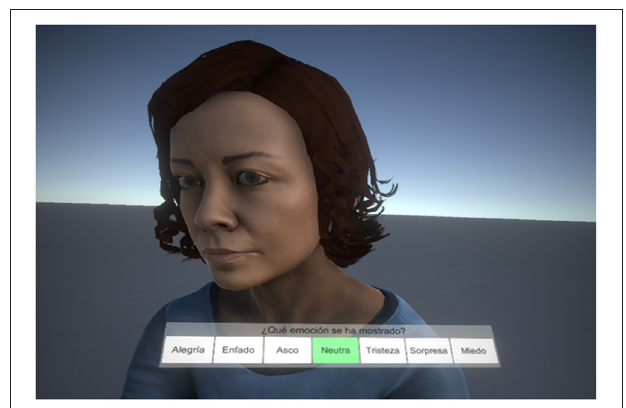
FIGURE 1 | Panel used by the participants to select the emotion depicted by the virtual human.